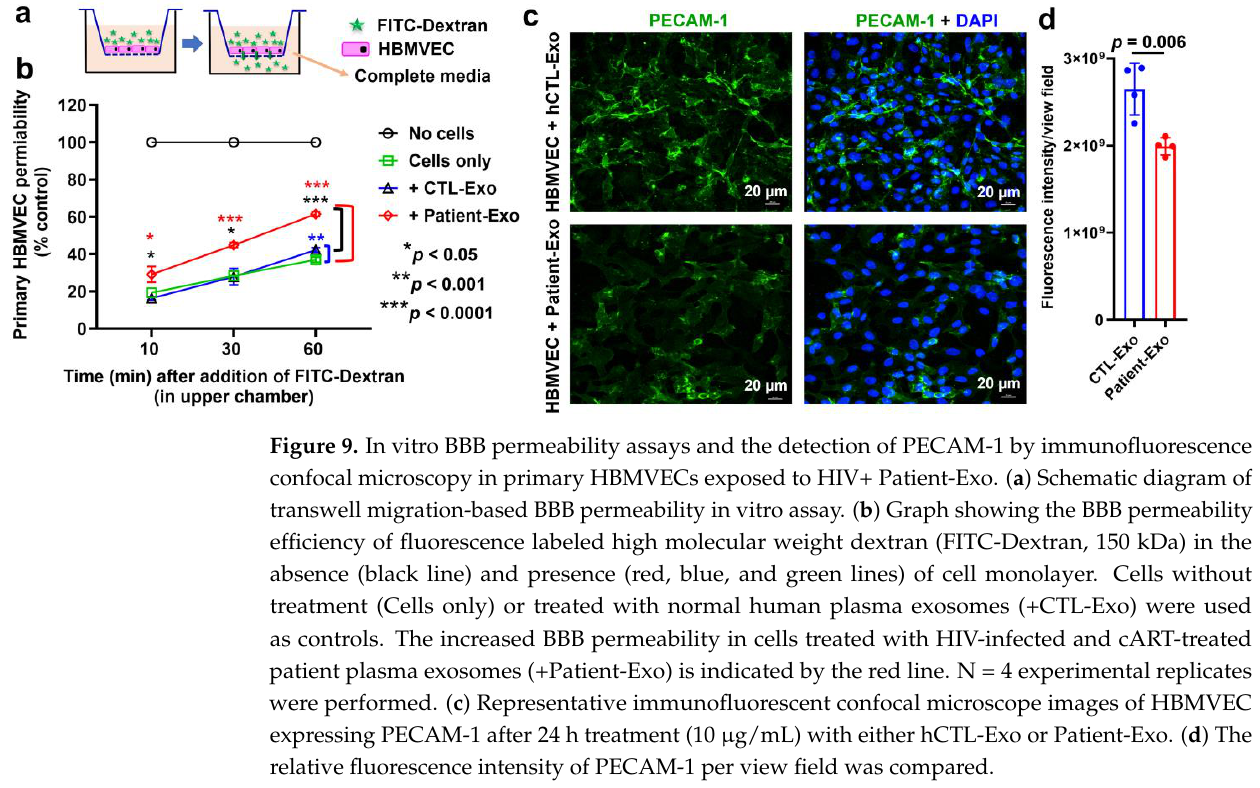
relative fluorescence intensity of PECAM-1 per view field was compared.